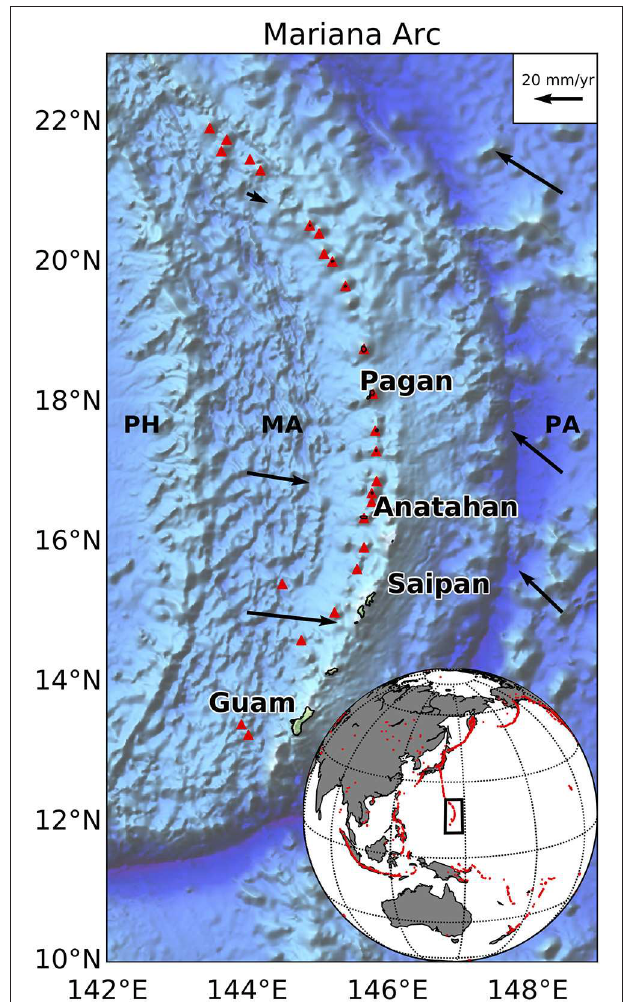
FIGURE 1 | Map showing location of Pagan Island. Bathymetry is from ETOPO1 dataset (Amante and Eakins, 2009), and red triangles represent active volcanoes of the Izu-Bonin-Mariana subregion defined in Siebert et al. (2011). Note that many of these volcanoes are submarine, including all red triangles north of 21 degrees. Plate motion vectors using the Global Strain Rate Model (GSRM v2.1) of Kreemer et al. (2014) are plotted as black arrows with a scale in the upper right. Motion of the Pacific plate (PA) and Mariana plate (MA) are with respect to the Philippine plate